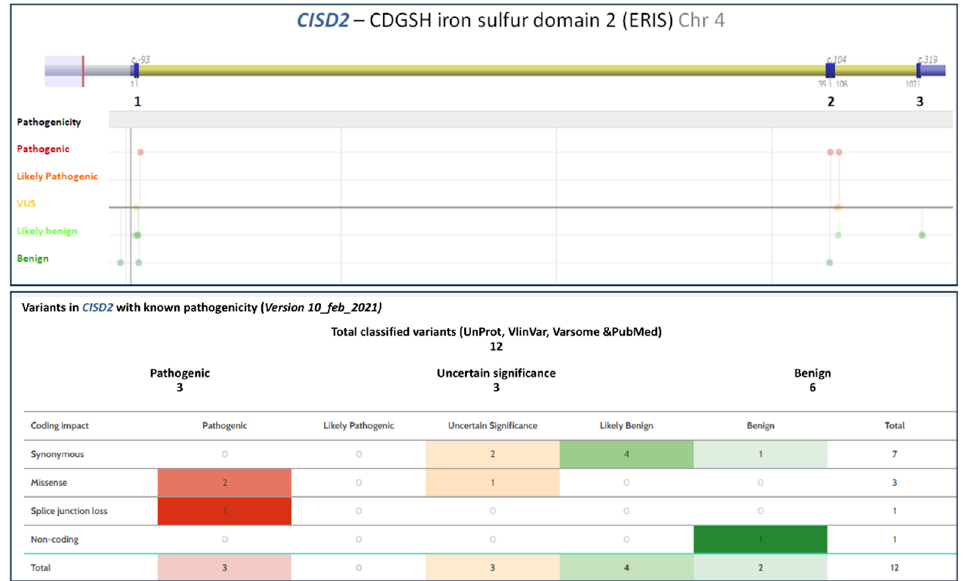
Figure 3. Genetic variant distribution in CISD2. Adapted from Alamut Visual version 2.15 (SOPHiA GENETICS, Lausanne, Switzerland) and from VarSome: The Human Genomic Variant Search